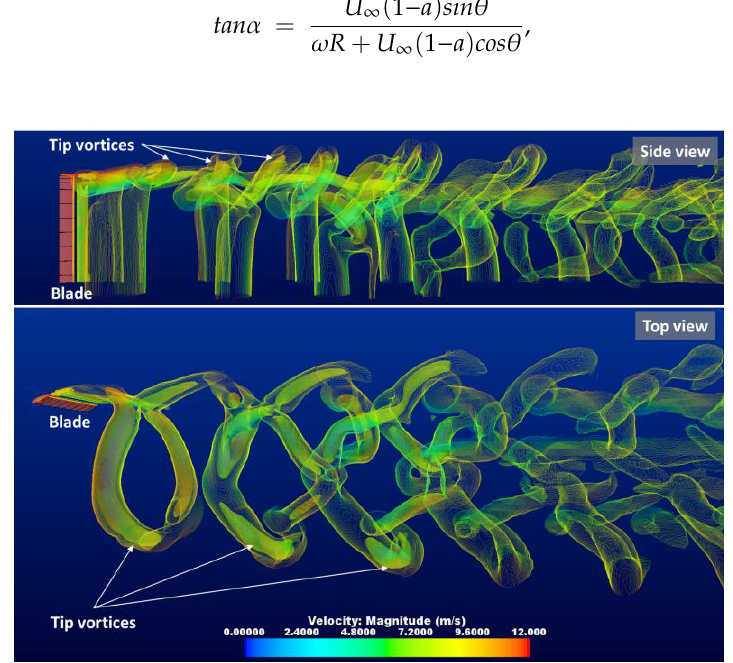
Figure 11. Collision between the blade and the vortex in the downwind. J. Mar. Sci. Eng. 2020 , 8 , x FOR PEER REVIEW